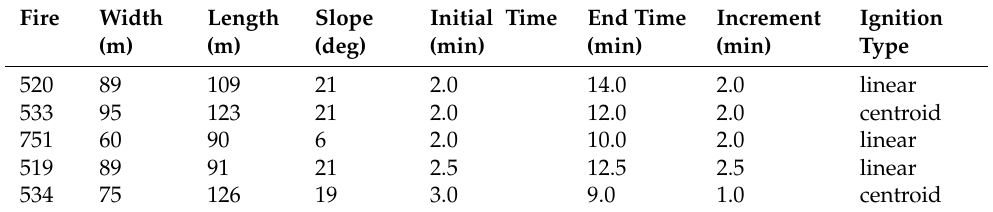
Table 2. Characteristics of the controlled fires. Each case is identified by a number in the first column. Fire